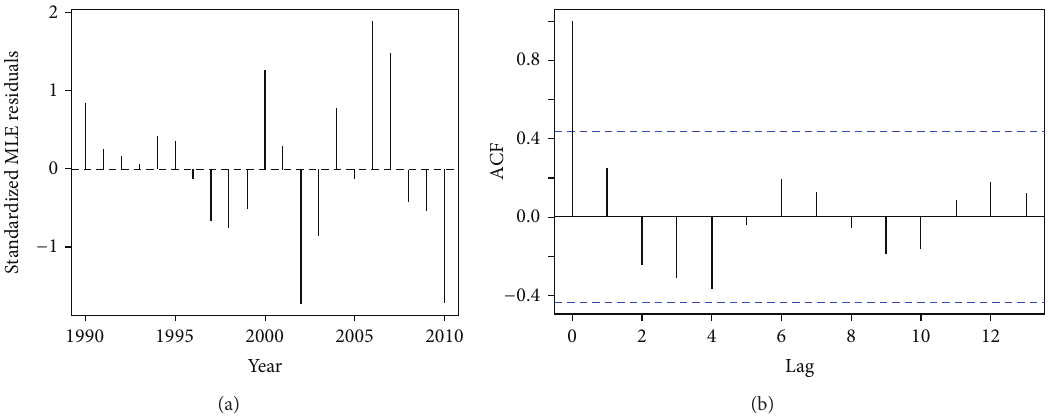
Figure 5: MLE residuals and their autocorrelation function.